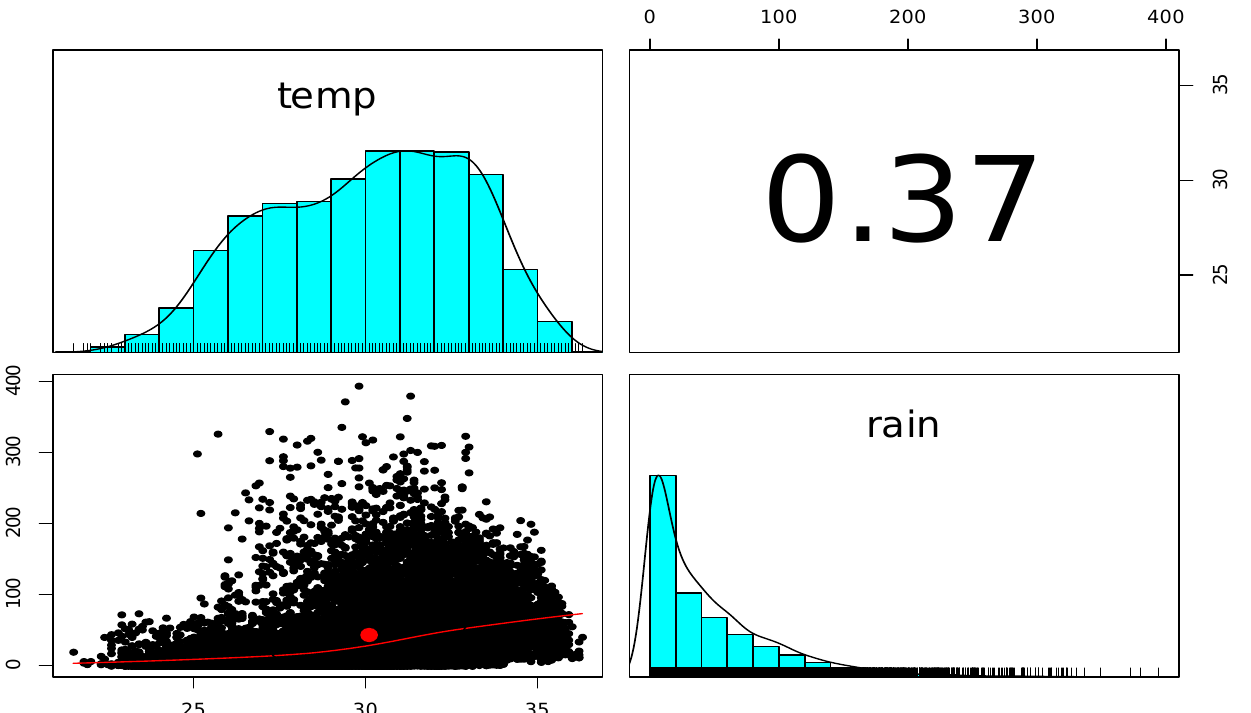
Figure 5. Histograms (diagonal), pairwise scatter plots (bottom left), and pairwise Kendall’s rank correlation coefficient (top right) of temperature and rainfall data for all the study area.